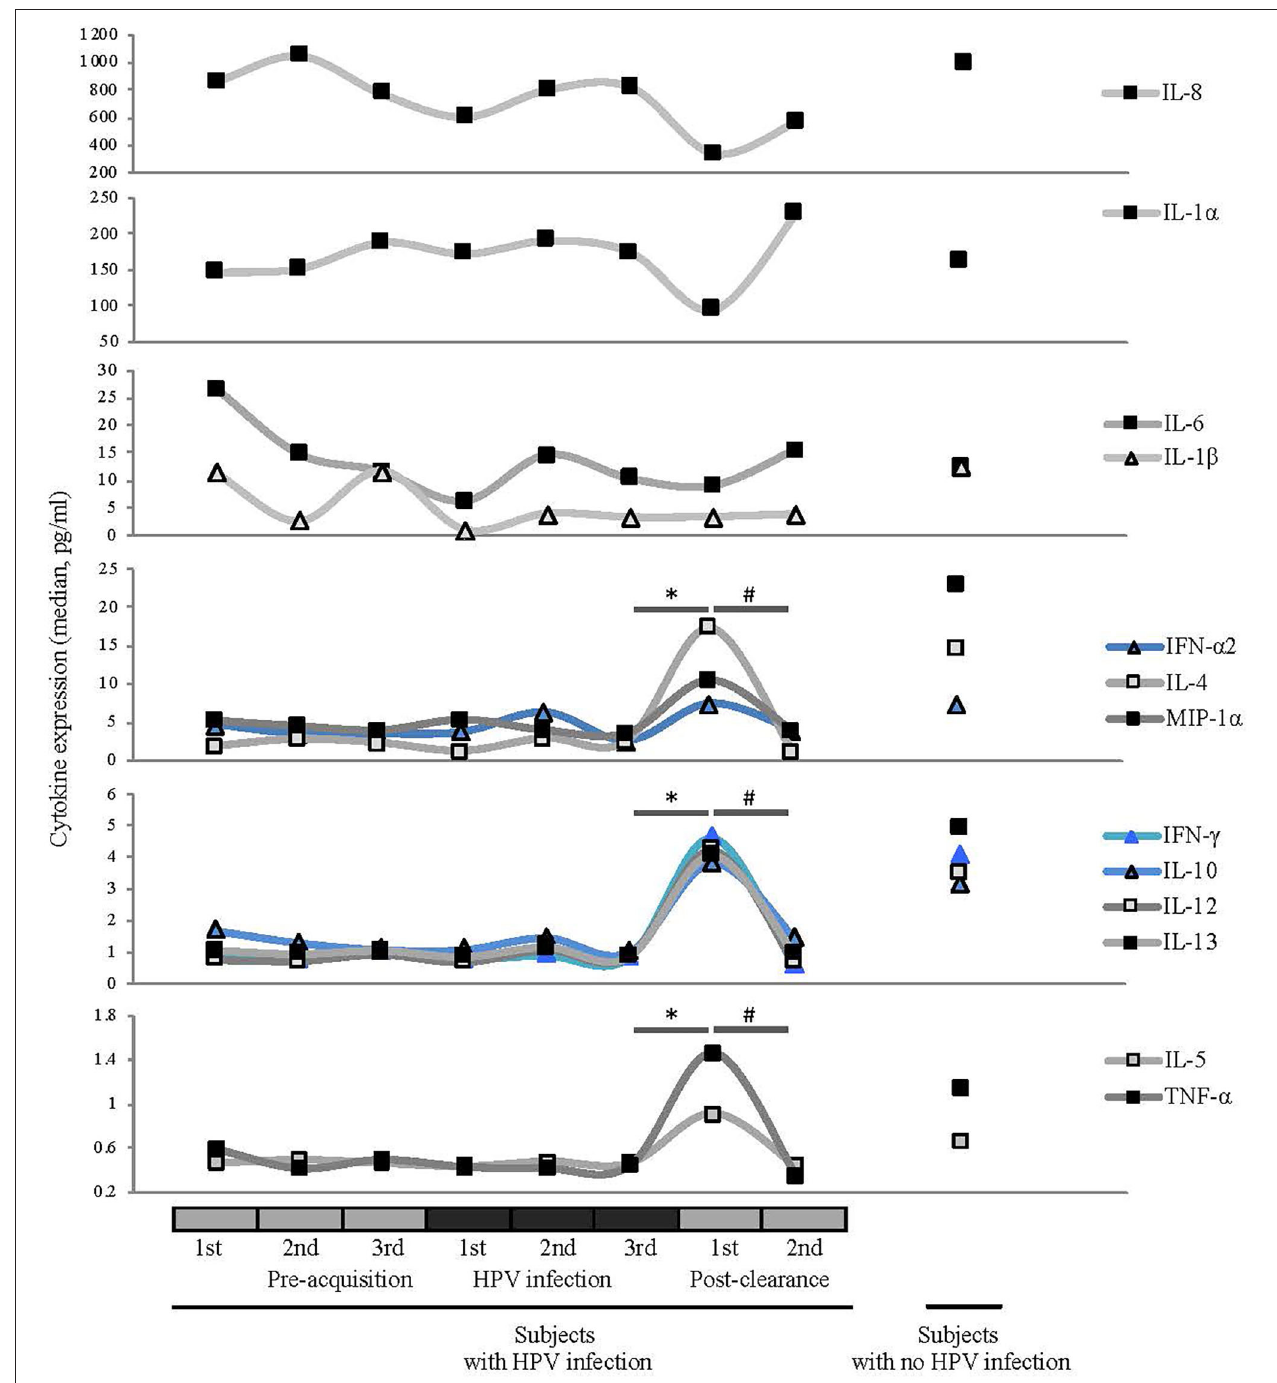
FIGURE 5 | Comparisons of median cytokine expression level (pg/ml) across different HPV 16 states (see Figure 1 for definitions). Wilcoxon rank-sum test was used in 8 pairwise testing of differences in the cytokines between immediate post-clearance and the 8 other clinical states including women with no history of HPV. Cytokines are grouped by the magnitudes of the expression levels. Expression levels of ILs-4, -5, -10, -12, and -13, IFN- γ , IFN- α 2, MIP-1 α , and TNF- α were significantly elevated at the immediate post-clearance visit compared to all the pre-acquisition and infection visits (all * p < 0.01) and 2nd post-clearance visit ( # p < 0.001). When compared to the immediate post-clearance visit, women with no history of HPV had similar levels of IFN- γ , IFN- α 2, and TNF- α , lower levels of ILs-4 ( p < 0.001), IL-5 ( p < 0.001), IL-10 ( p = 0.02), and IL-12 ( p = 0.02) and higher levels of IL-13 ( p = 0.02) and MIP-1 α ( p < 0.001).